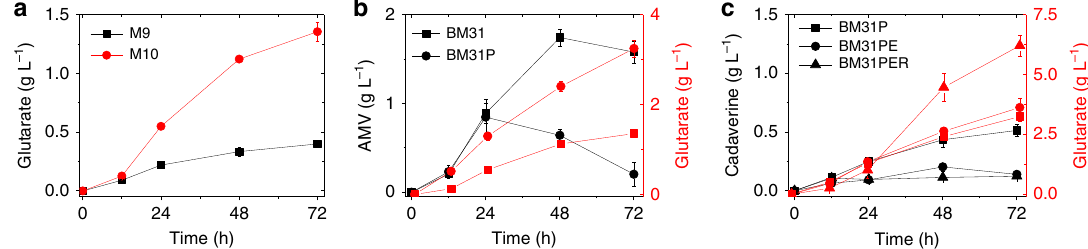
Fig. 5 De novo biosynthesis of glutarate. a Comparison of glutarate production in M9 and M10 media. b Comparison of glutarate production and AMV accumulation by strains BM31 and BM31P. c Comparison of glutarate production and cadaverine accumulation by strains BM31P, BM31PE, and BM31PER. Data shown are mean ± SD ( n = 3 independent experiments). Source data are provided as a Source Data fi